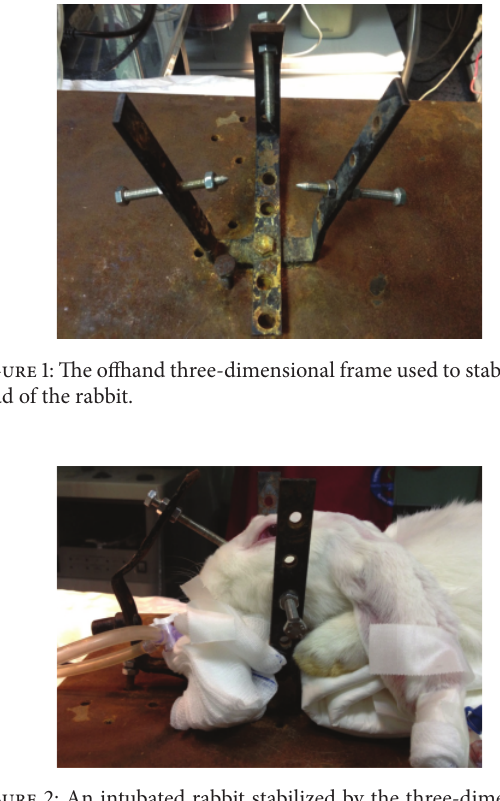
Figure 2: An intubated rabbit stabilized by the three-dimensional